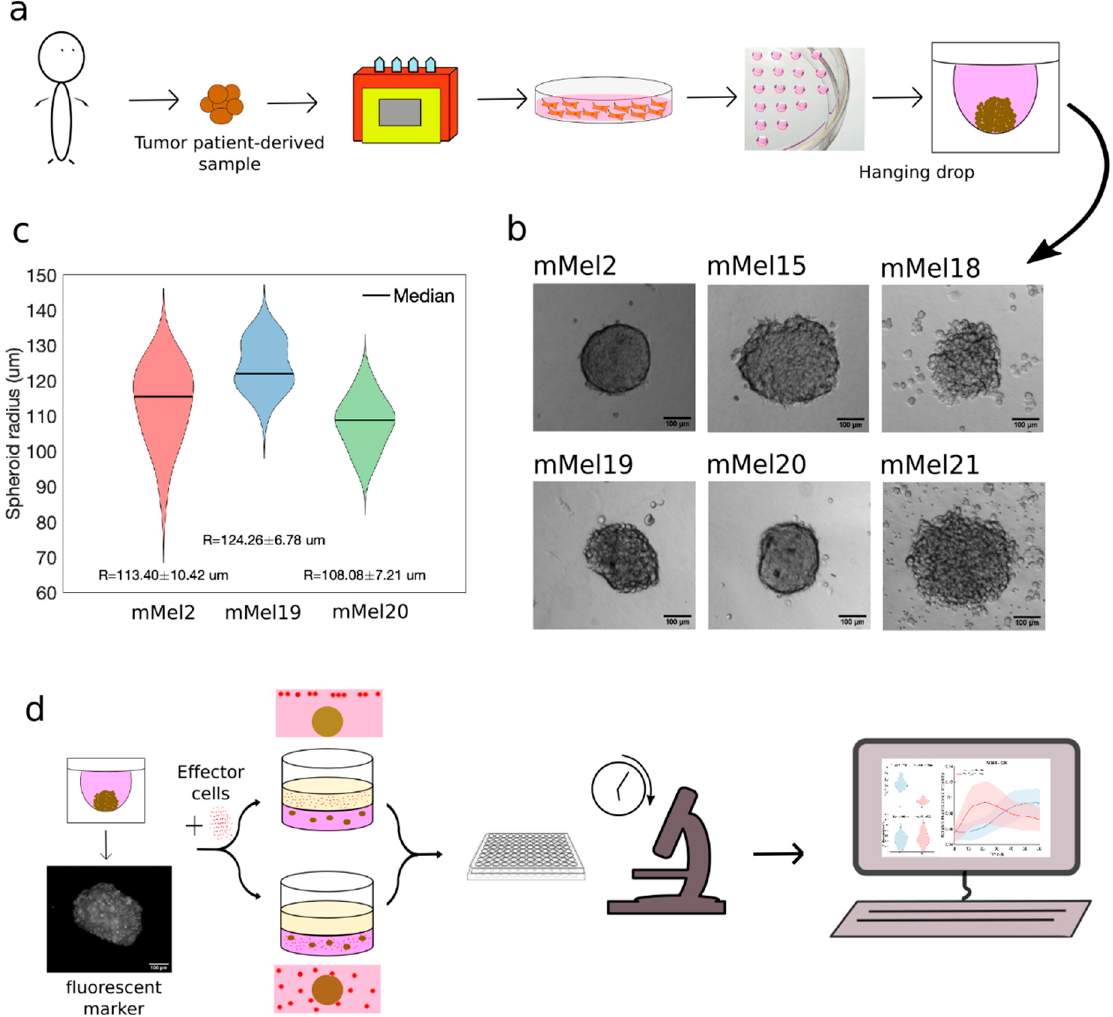
Figure 1. Establishment of a 3D model for the study of adoptive cell therapy against primary melanoma tumor samples. ( a ) Outline of spheroids formation. Melanoma patient-derived samples were processed to obtain primary cell lines. In order to obtain spheroids, cells were grown with the hanging drop technique. ( b ) We tested eight different primary melanoma samples for their ability in forming spheroids and successfully obtained spheroids from six of eight samples. Slightly different degree of compactness was observed, as expected, due to the heterogeneity of the different samples. ( c ) Violin plots indicate width and local density of the statistical distribution. Different colors refer to different samples, as indicated in the X tick. Numbers indicated report mean and standard deviation. ( d ) Sketch of the experimental procedure for the 3D embedding of target-effector co-cultures: Tumor spheroids and effectors were incubated with different fluorescent labeling agents and embedded in the appropriate ratio in a collagen gel (bottom) or spheroids were embedded and effectors added with the media on top of the gel (top). Imaging well plates were used to then monitor the assay with a motorized inverted microscope of choice. Digital images were post-processed for quantification and data analysis.